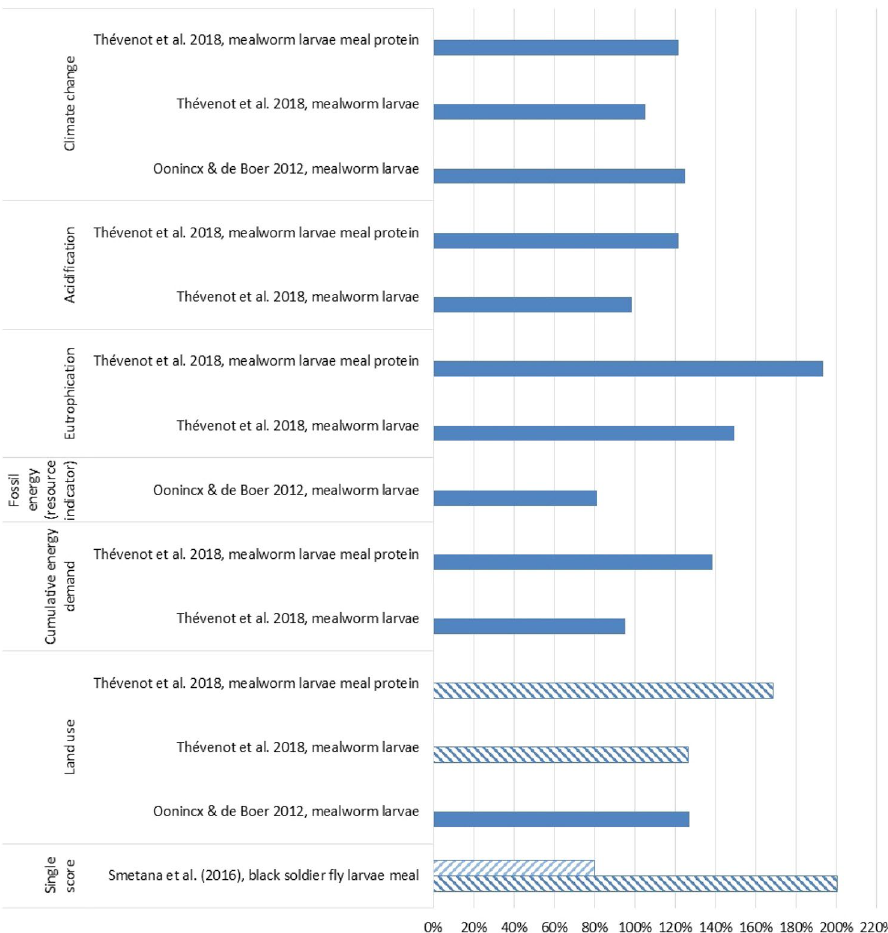
Fig. 2 Results for the repro- duced studies relative to the originals (original results are defined as 100% for each indi- cator in each study). The figure shows only the reproduced